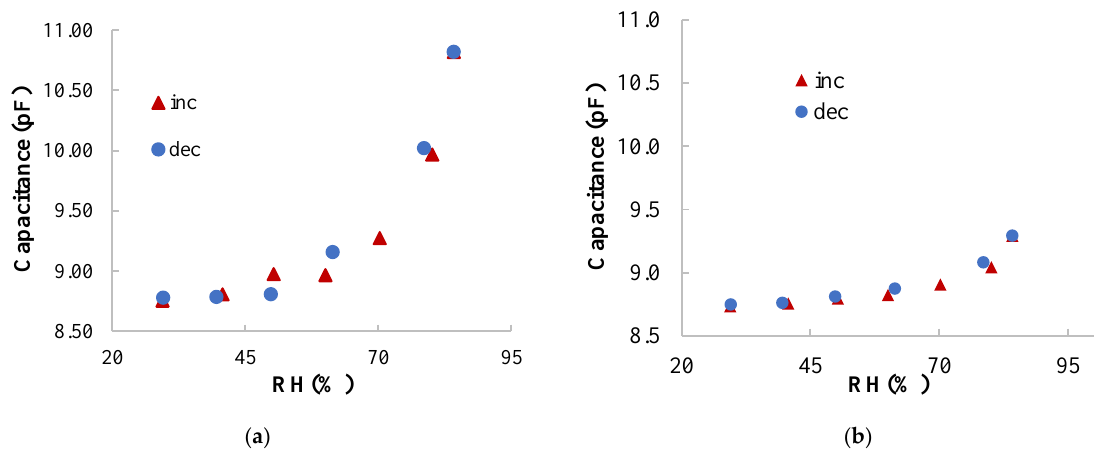
Figure 4. Calibration curves increasing and decreasing RH at 1 kHz ( a ) and 10 kHz ( b ). In both graphs, it is shown the responses when RH is increasing (inc) and decreasing (dec). Table 1. Calibration curves extracted from Figure